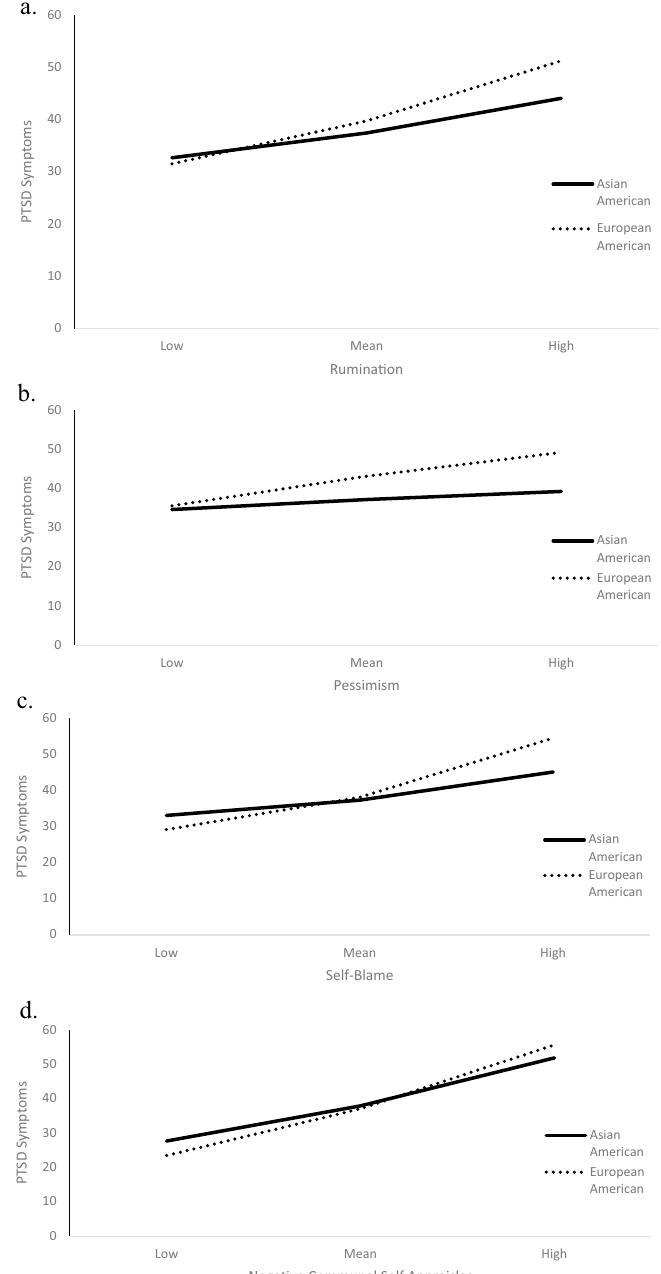
Figure 2. Figure depicting slimple slopes for rumination ( a ), pessimism ( b ), self-blame ( c ) and negative communal self-appraisals ( d ) moderation